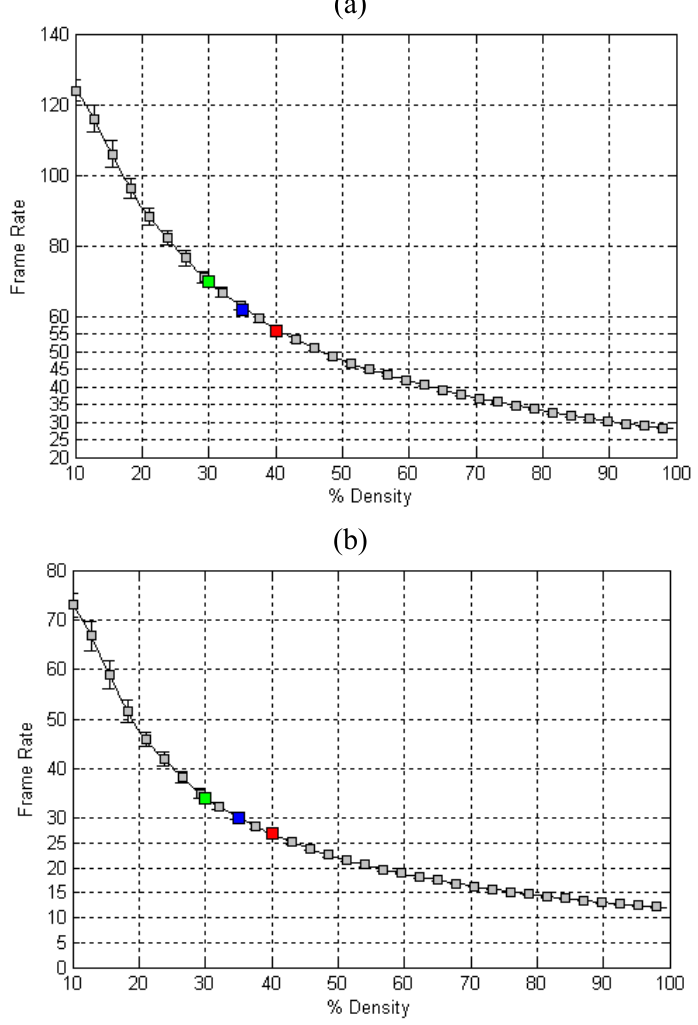
Figure 6. (a) System performance using pre-selected points of interest and 5 × 5 SIB. (b) System performance using pre-selected points of interest and 9 × 9 SIB. Colored mark illustrates three typical scenarios using different image edge densities. The green mark makes reference to the best performance cases (scenes with low edge density), the blue one, to the most common density values (normal scenes) and the red mark, to the worst cases (scenes with high edge density). The error bar represents the standard deviation of the results for 10